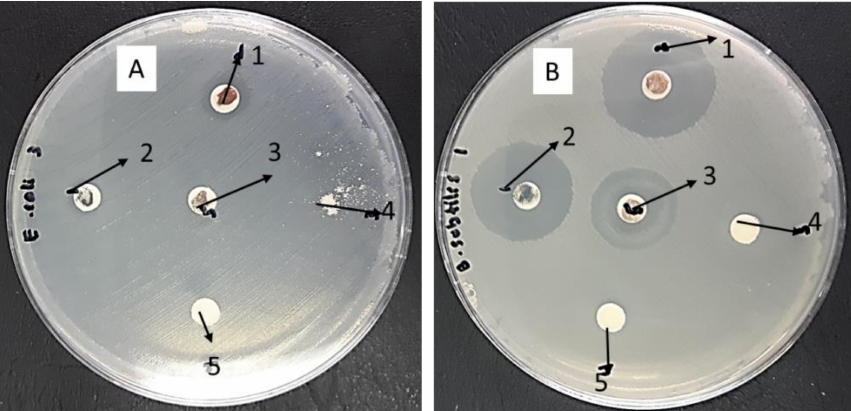
Figure 11. Inhibition zone test for Escherichia coli ATCC 25922 Gram ( − ve ) ( A ) and Bacillus subtilis UPMC 1175 Gram (+ ve ) ( B ), the nanoparticle samples (1 at 500 ◦ C, 2 at 600 ◦ C, 3 at 700 ◦ C, and 4 at 800 ◦ C), with lower activity observed in the bulk suspensions (5).